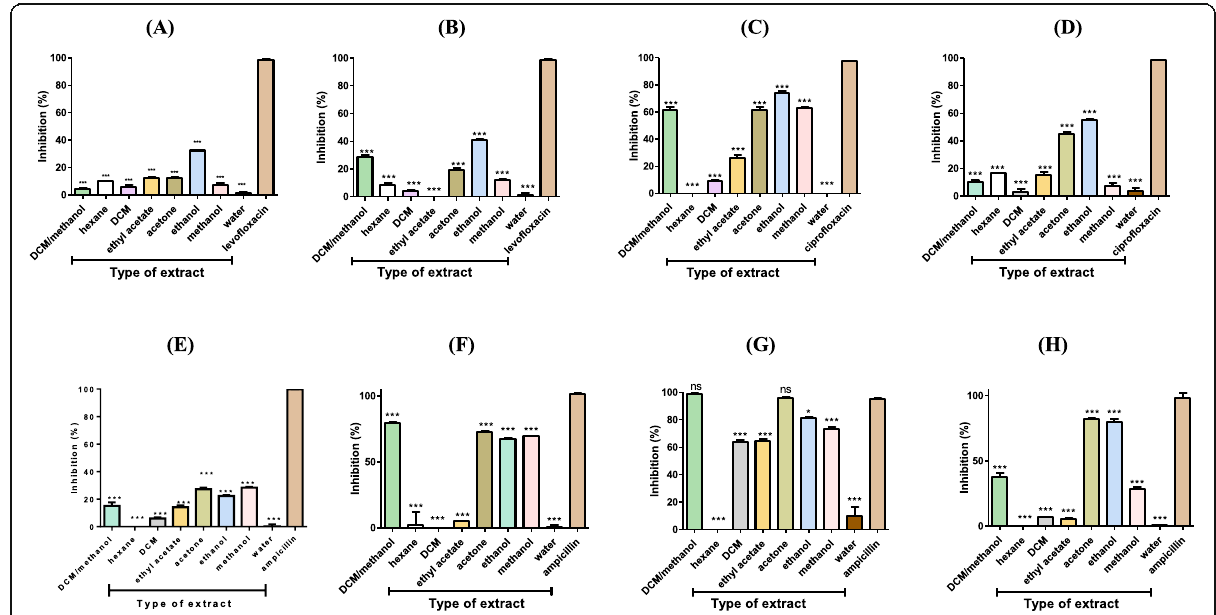
Fig. 2 Percentage inhibition of bacterial cells upon treatment with 100 μ g/ml extract from leaves of T . welwitschii . a K. pneumoniae , b S. pneumoniae , c S. pyogenes , d B. subtilis , e ATCC strain of S. aureus , f clinical strain of S. aureus , g ATCC strain of P. aeruginosa , and h clinical strain of P. aeruginosa . Values are for mean ± standard deviation (error bar) for n = 4. The asterisks indicate a significant difference from the control with * p < 0.05, *** p < 0.001 and ns mean no significant